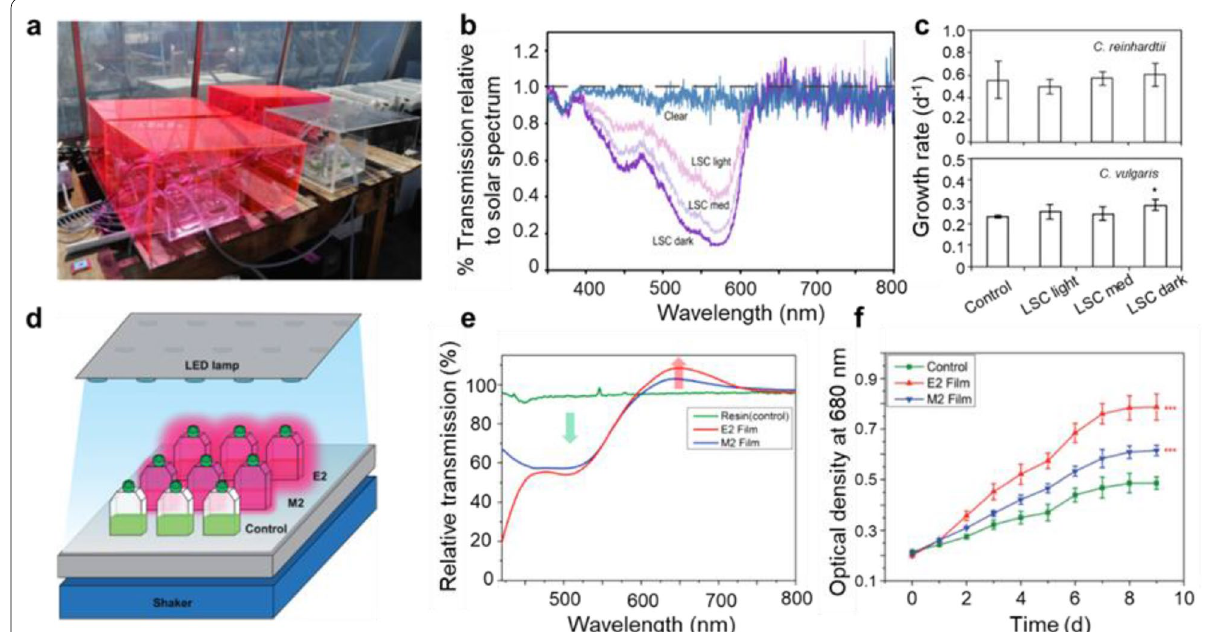
Fig. 8 a Photograph of microalgae in photobioreactors that were placed in water baths underneath spectral conversion panels and a clear panel. b Transmission spectra (350–800 nm) for the three LSC panels and the control panel relative to the solar spectrum recorded outside on a clear day. c Growth rates are represented by bar graphs for C. reinhardtii and C. vulgaris algae. Reproduced with permission [82]. d Schematic method of fabricating the photobioreactor for algae cultures and schematic experimental setup of microalgal cultivation. e Transmittance change of thin films